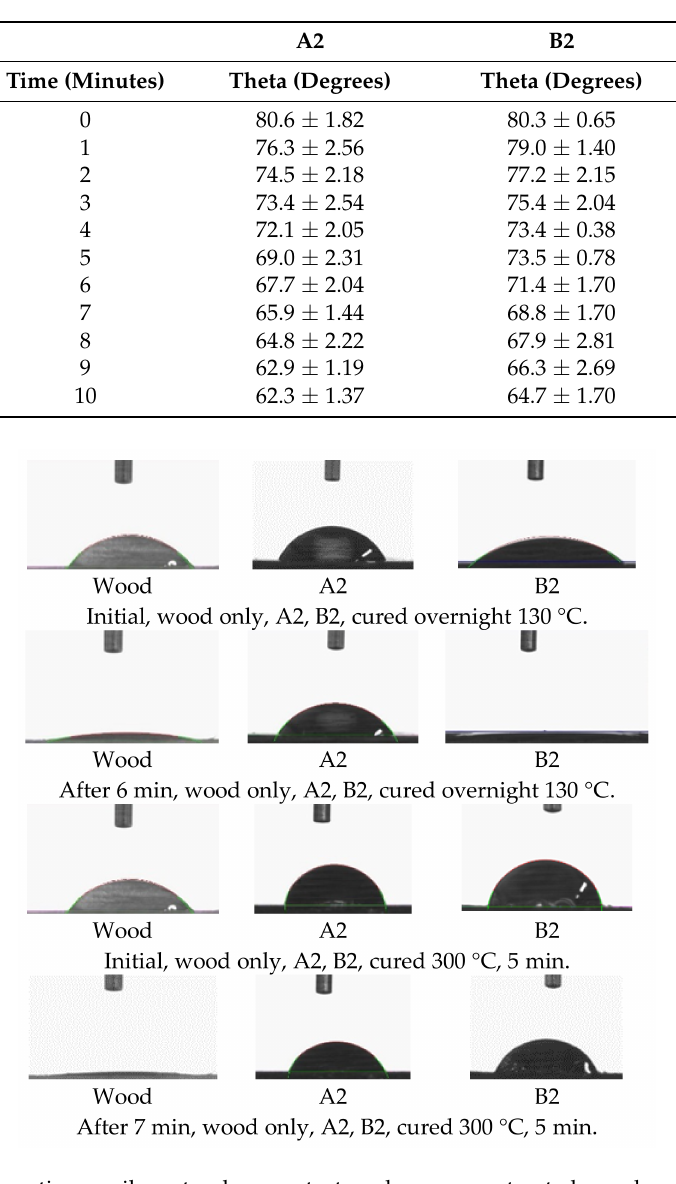
Figure 20. Comparative sessile water drop contact angles on an untreated wood surface, on a wood surface treated with a glucose-based A2 coating, and on a wood surface treated with a sucrose-based B2 coating. The initial angle when cured overnight at 130 ◦ C ( top ). The angle after 6 min wetting when cured overnight at 130 ◦ C ( second from Top ). The initial angle when cured at 300 ◦ C for 5 min ( second from Bottom ). The angle after 7 min wetting when cured at 300 ◦ C for 5 min ( bottom ). The contact angles of water sessile drops on any wood surfaces tend to decrease with contact